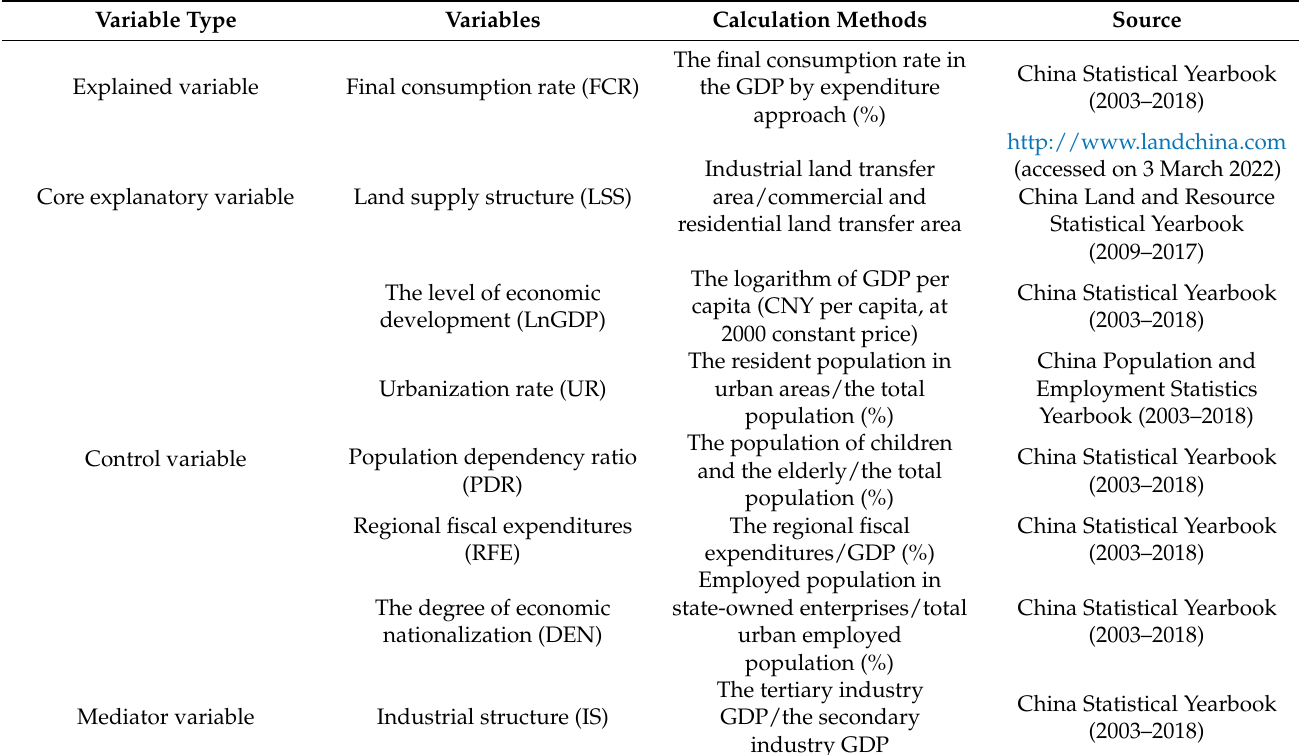
Table 1. Variable description.